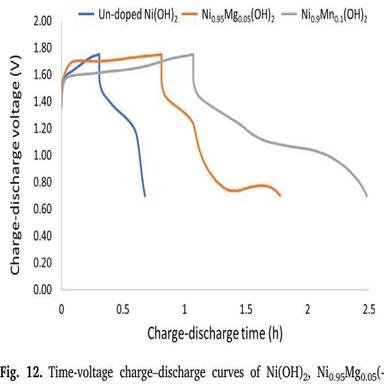
Cyclic voltammograms of (a) Ni(OH)2, (b) Ni0.95Mg0.05(OH)2 (c) Ni0.9Mn0.1(OH)2.